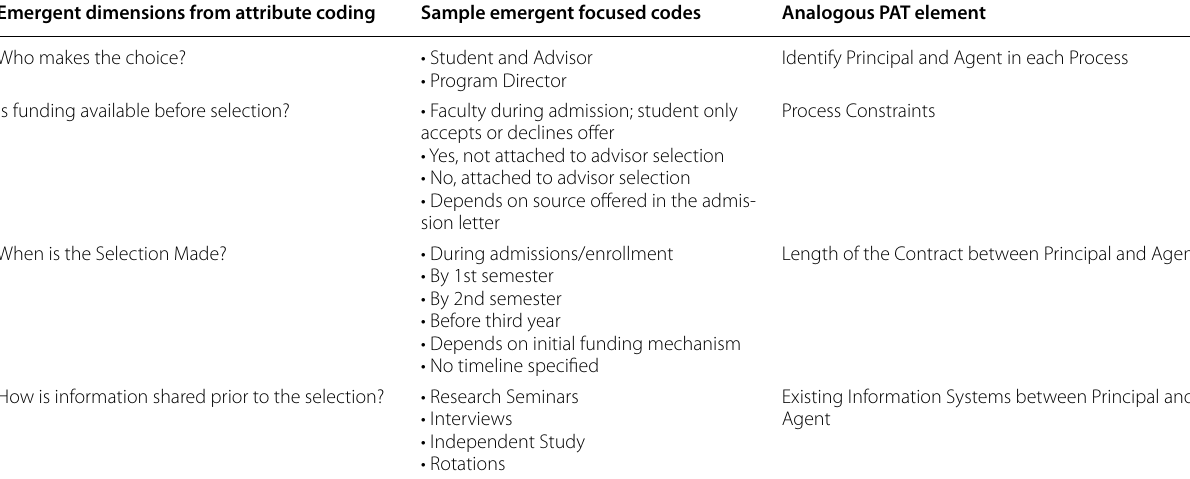
Table 1 Analysis coding process Emergent dimensions from attribute coding Sample emergent focused